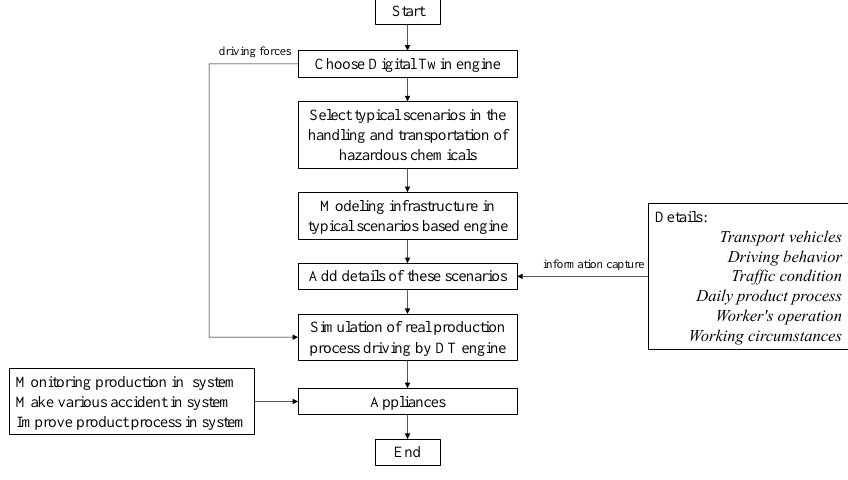
Figure 2. The framework of the constructure of DT system for hazardous chemicals.